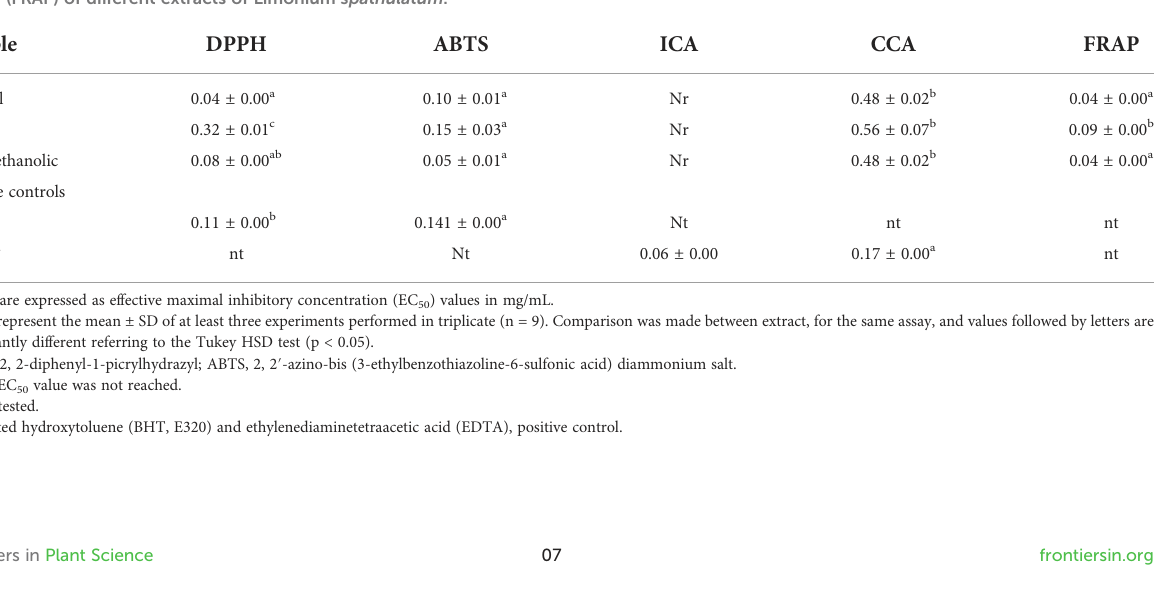
Values represent the mean ± SD of at least three repetitions (n = 3). The extracts were tested for trypsin and amylase inhibition at 1 mg/mL, for phytic acid quanti fi cation up to 150 mg/mL. nd, not detected.